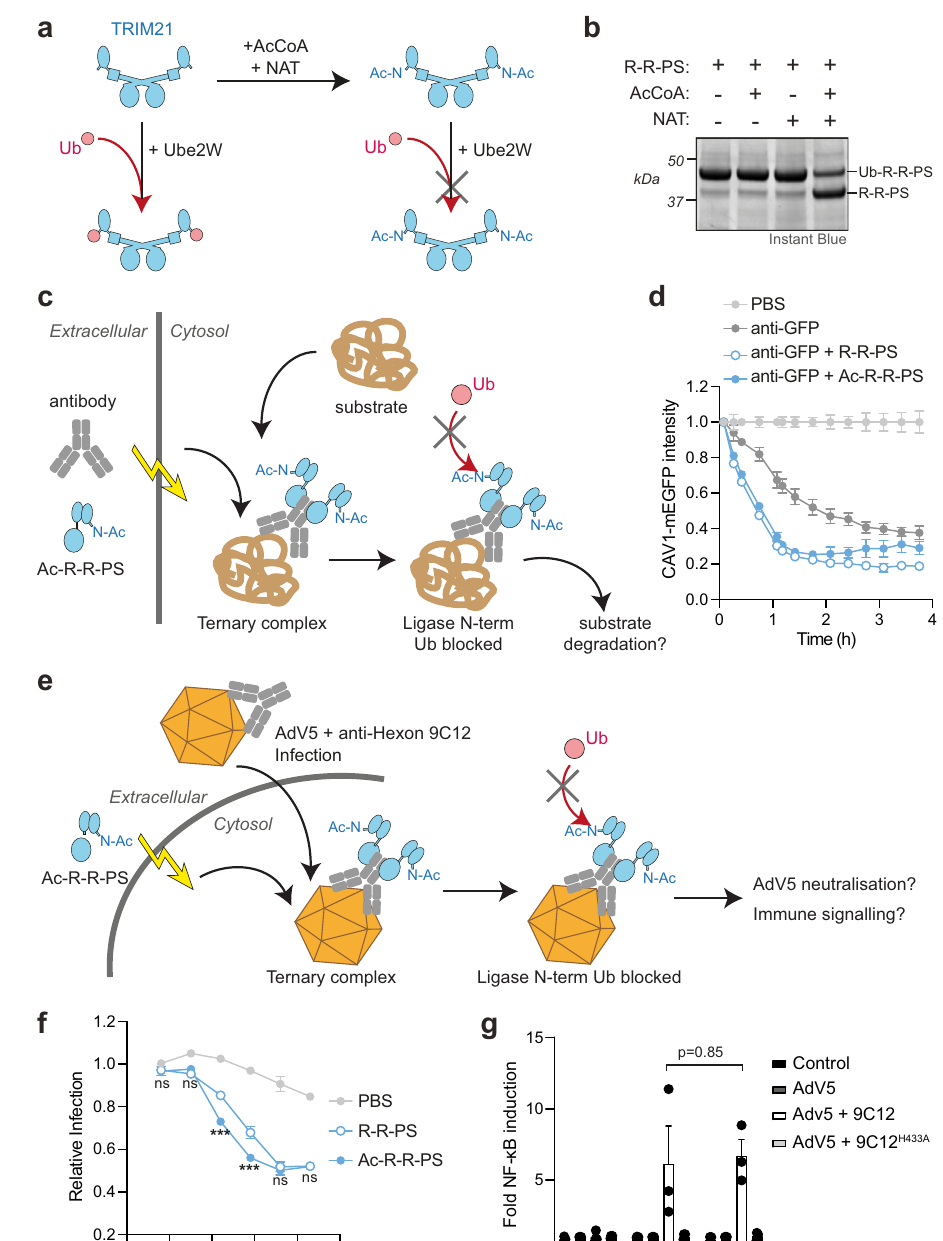
Fig. 2 | Ligase N-terminal ubiquitination is not required for substrate degra- dation and antiviral activity. a Schematic showing N-terminal acetylation of TRIM21 by AcCoA and NAT and then incubation of the acetylated or unmodi fi ed ligasewithubiquitin(Ub)andUbe2Winaubiquitinationreaction. b Protein-stained gel of ubiquitination reaction depicted in ( a ) using R-R-PS ligase. Mono- ubiquitination of R-R-PS thathasbeenincubated with AcCoA and NATisinhibited. Representativeexamplefrom n =3independentexperiments. c Schematicshowing Trim-Awayexperimentinwhichantibodyiselectroporatedintocellstogetherwith Ac-R-R-PS. Once inside cells, a ternary complex with the substrate is formed. If degradation is driven by ligase N-terminal ubiquitination, then Ac-R-R-PS activity will be inhibited. d Results of Trim-Away experiment described in ( c ). RPE-1 CAV1- mEGFP cells were electroporated with PBS or anti-GFP antibody±R-R-PS proteins and CAV1-mEGFP fl uorescence was quanti fi ed using the IncuCyte system. Time showshours(h)post-electroporation.Valuesnormalized to PBScontrolcondition. Graphs shows mean and s.e.m. from n =4 technical replicates. Representative